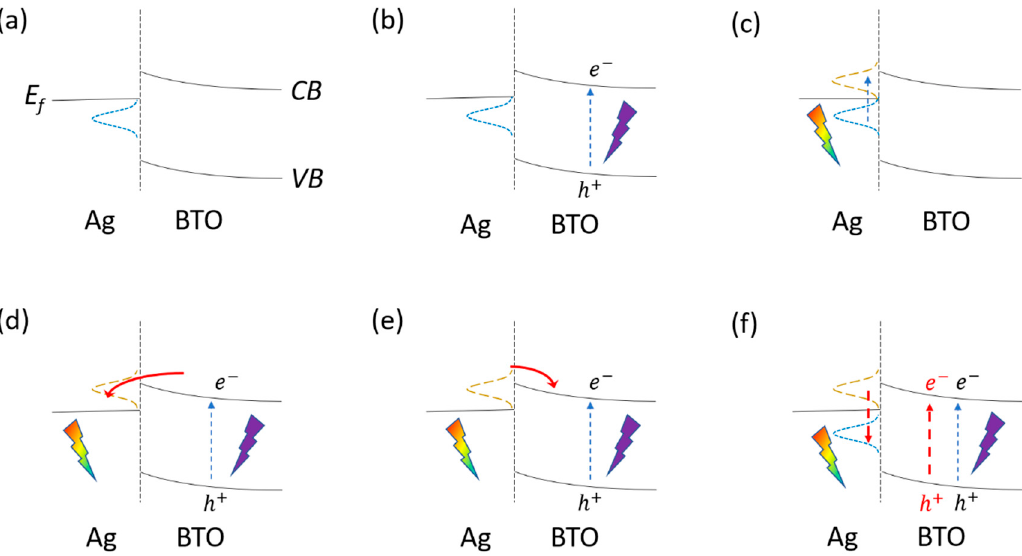
Figure 8. The schematic diagrams of charge transfer paths of Ag–BTO. ( a ) Schottky contact of Ag– BTO. ( b ) UV excitation. ( c ) Visible light excitation. ( d – f ) The transfer paths of ( d ) charge separation, ( e ) hot-electron injection, and ( f ) PIRET.